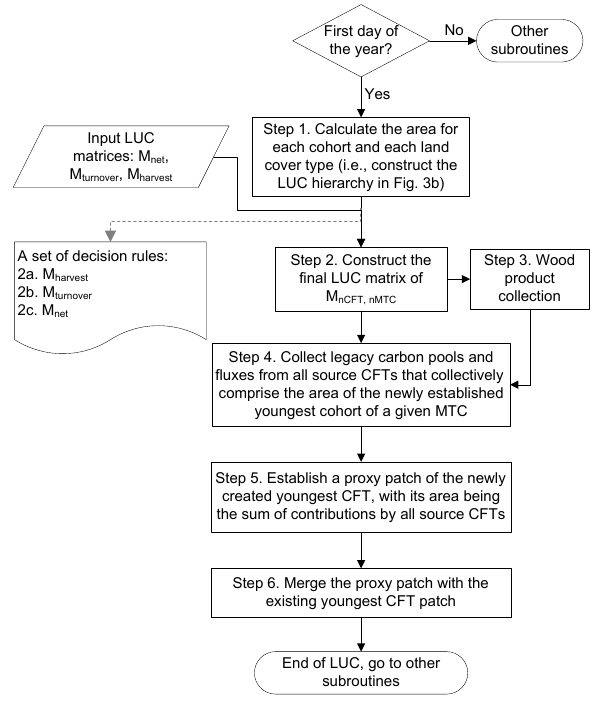
Figure 4. Schematic representation of the new LUC scheme in ORCHIDEE-MICT v8.4.2 accounting for net land use change, land turnover, and forest harvest in combination with sub-grid cohort